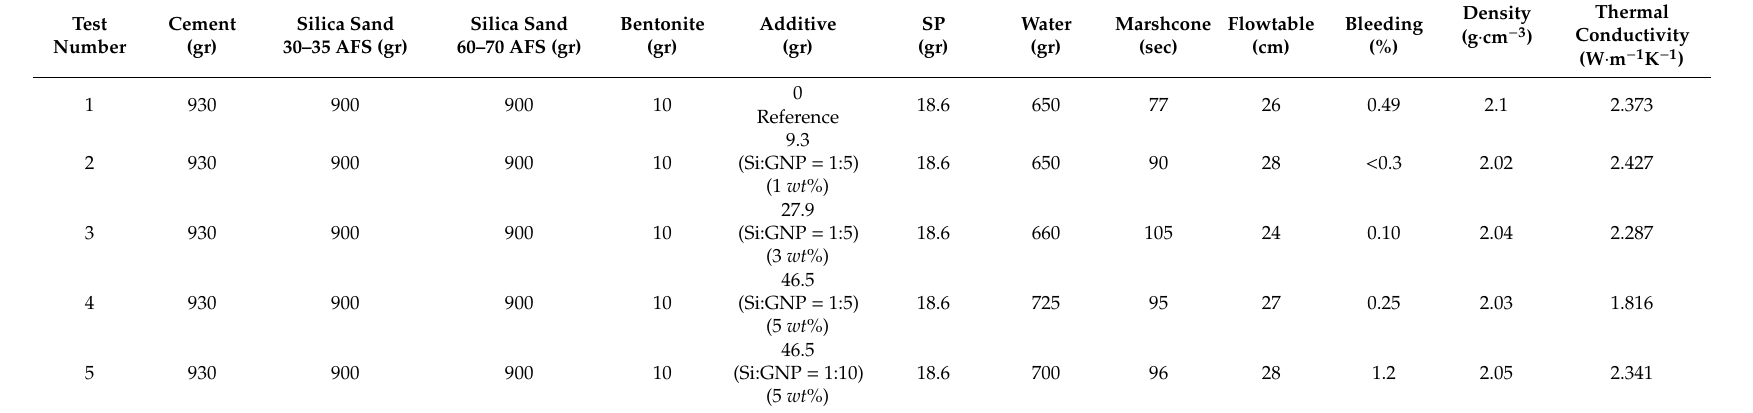
Table 2. Thermal conductivity results and rheological properties of selected reference grout and samples having hybrid